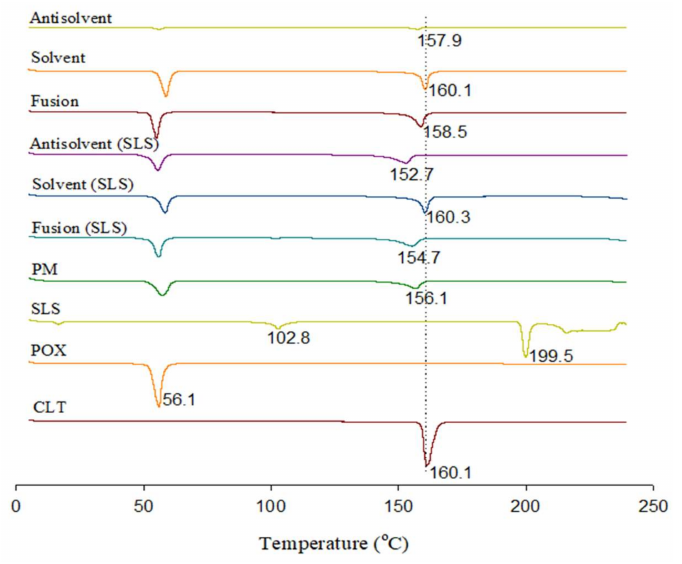
Figure 2. Differential scanning calorimetry thermograms of pure cilostazol (CLT), poloxamer, sodium lauryl sulfate (SLS), physical mixture (PM), and solid dispersions